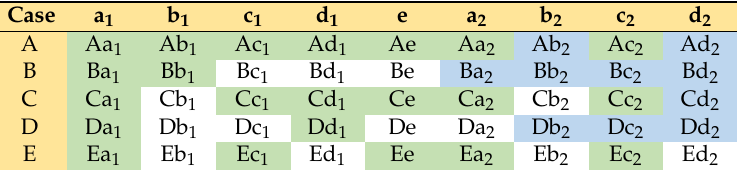
Figure 5. Basic winding methods for the receiving coil, where Rx winding can cover the whole sphere. Cases ( a 1 – d 1 ) cover the upper hemisphere of the small sphere, case ( e ) covers the middle area, and cases ( a 2 – d 2 ) cover the lower hemisphere of the small sphere. Table 1. Combination methods of the transmitter and receiver winding methods.